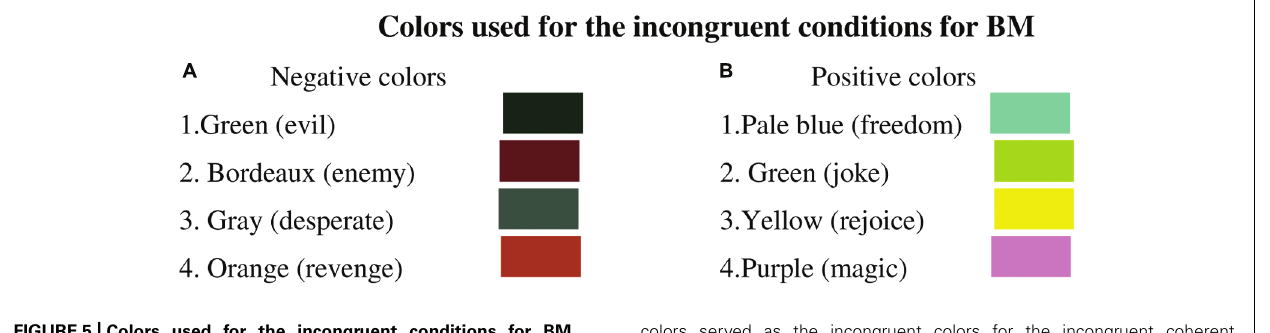
FIGURE 5 | Colors used for the incongruent conditions for BM. (A) negative colors served as the incongruent colors for the incongruent coherent condition for negative words and the incongruent incoherent condition for positive words. (B) Positive